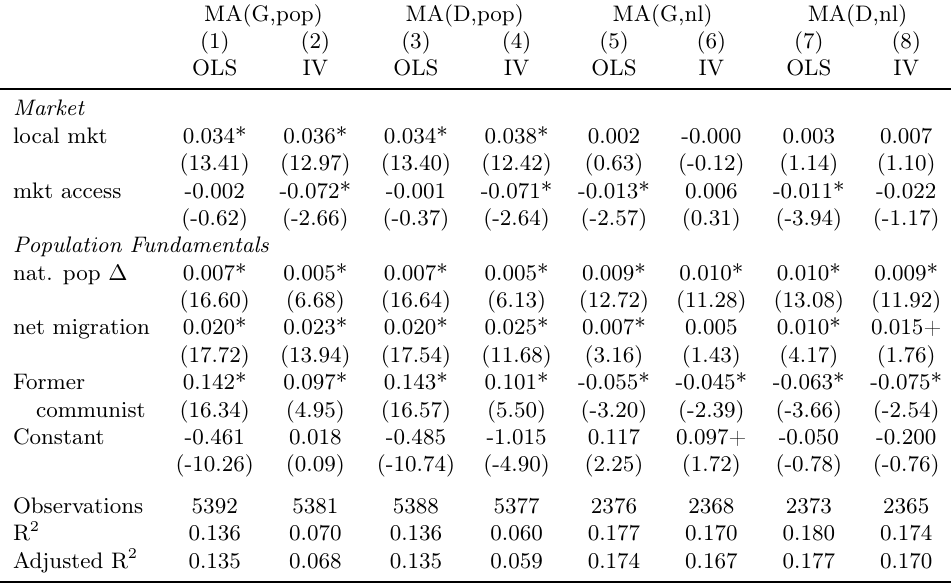
Table 4: The market access (MA) definitions follow notation in Table 3. The dependent variable is the annual population growth between year 2 and